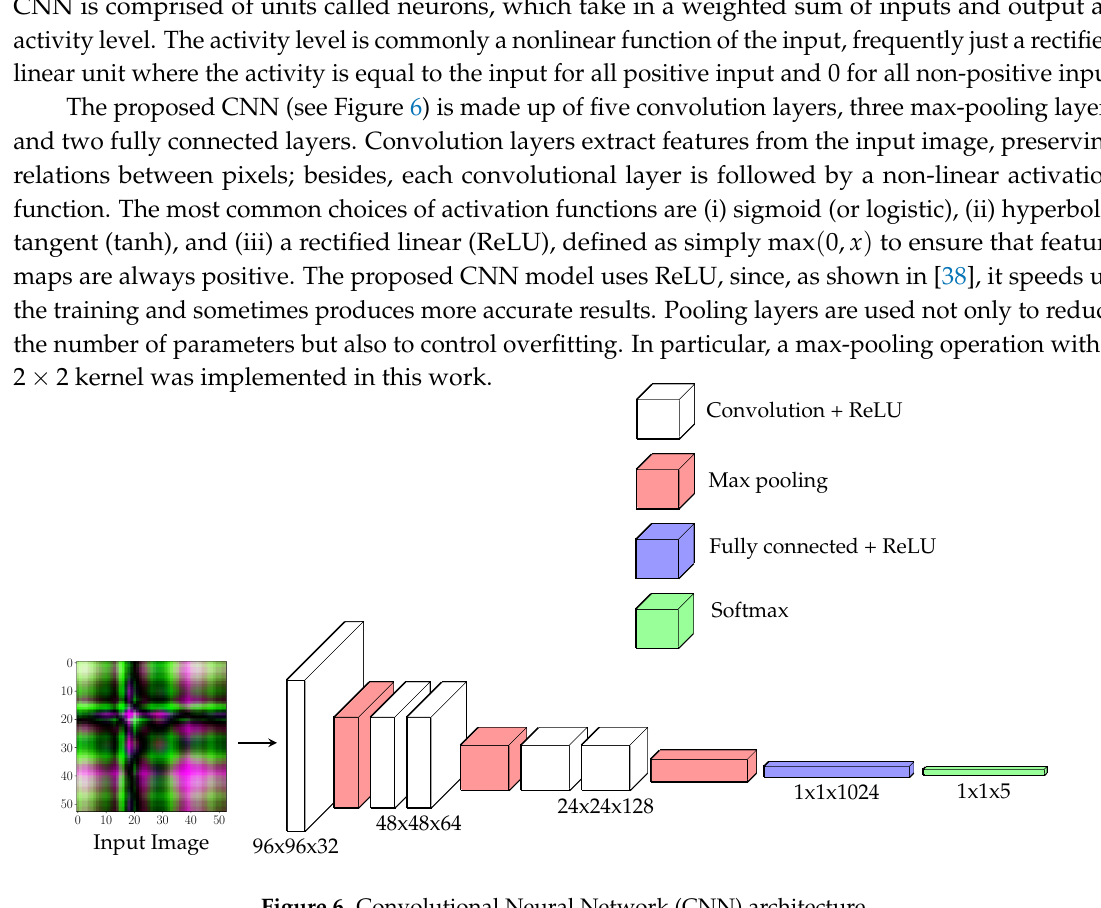
Figure 6. Convolutional Neural Network (CNN)